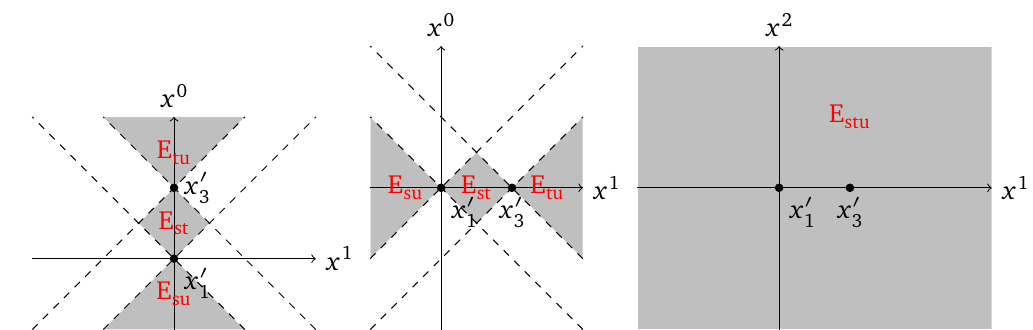
Figure C.1: The conformal frame configurations realized by configurations in class